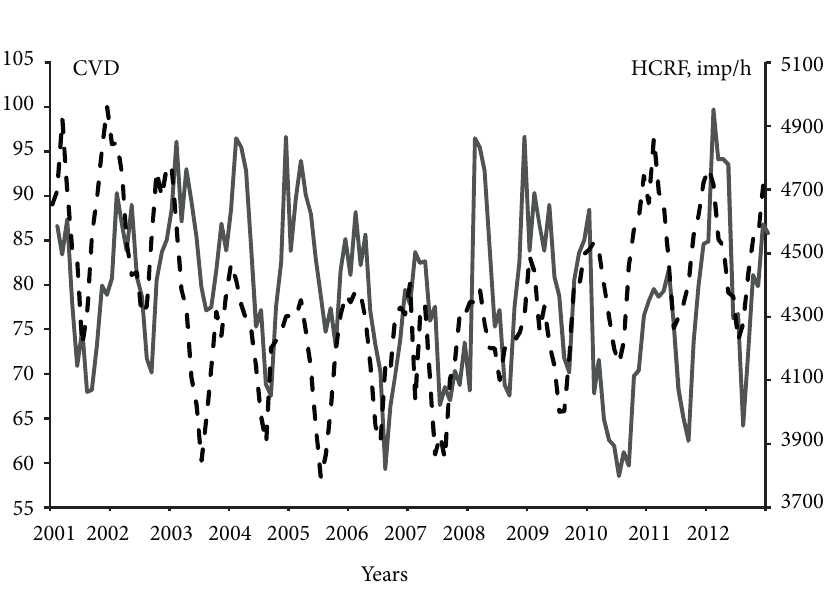
Fig. 3. Monthly average values in Vilnius in 2001–2012: in Vilnius: cardiovascular diseases (___),